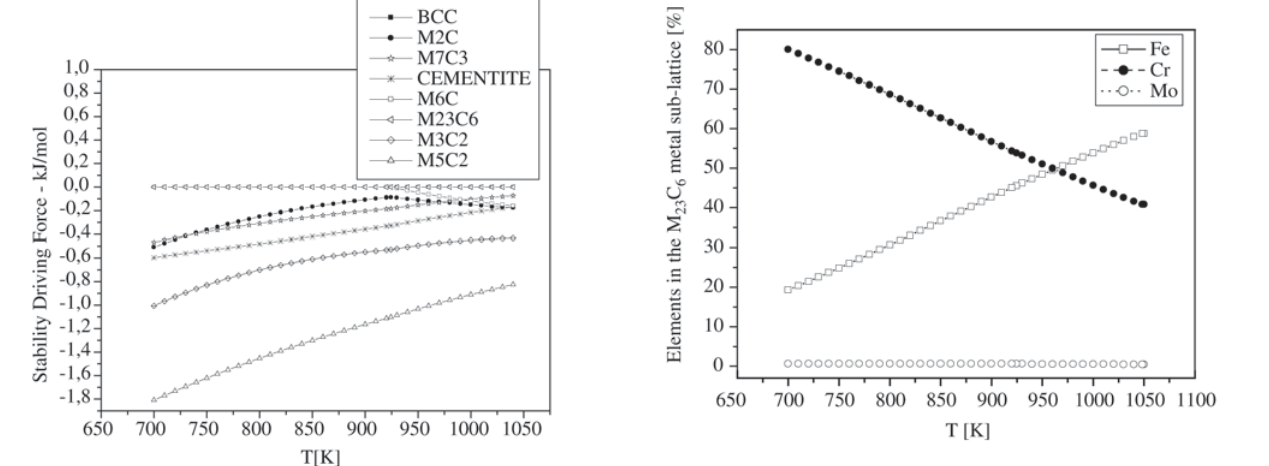
C and M C. 23 6 6